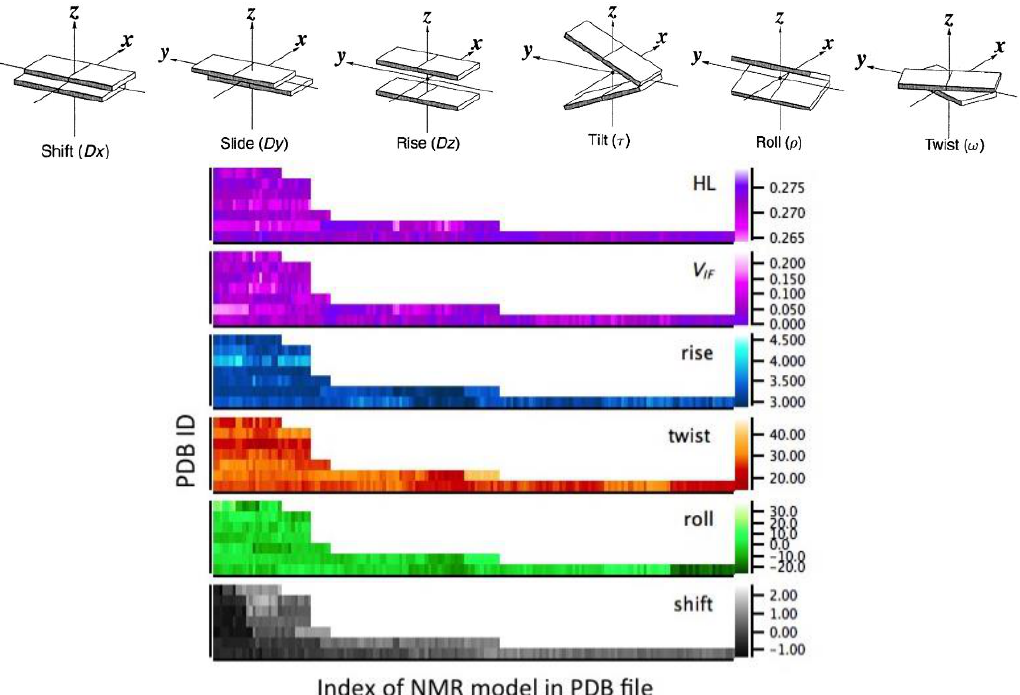
Figure 1. Distributions (normalized counts) of the computed transfer integral values for the three topology groups across the NMR structural models. The vertical axis reports the normalized counts. The group topologies are sketched in Figure 2 of Reference [9].